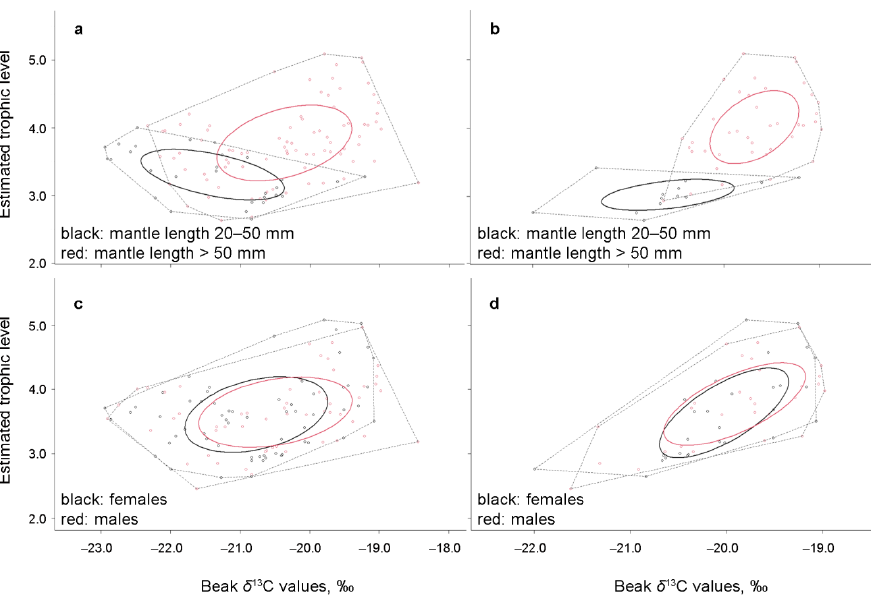
Figure 5. Isotopic niches in Gonatus fabricii at the population level, estimated in SIBER 2.1.6: ( a ) ontogenetic approach, all samples (West and East Greenland, and the Barents Sea), ( b ) ontogenetic approach, West Greenland, ( c ) Sexes, all samples (West and East Greenland, and the Barents Sea), and ( d ) sexes, West Greenland. Table 5. Isotopic niche metrics (TA, SEA c , and SEA b ) and overlap in Gonatus fabricii within different studied areas, estimated in SIBER 2.1.6. SEA b values are means ± SD. Significant p -values are in bold . Significant overlap values are in bold . ML: mantle length, n : sample size, ---: not applicable.